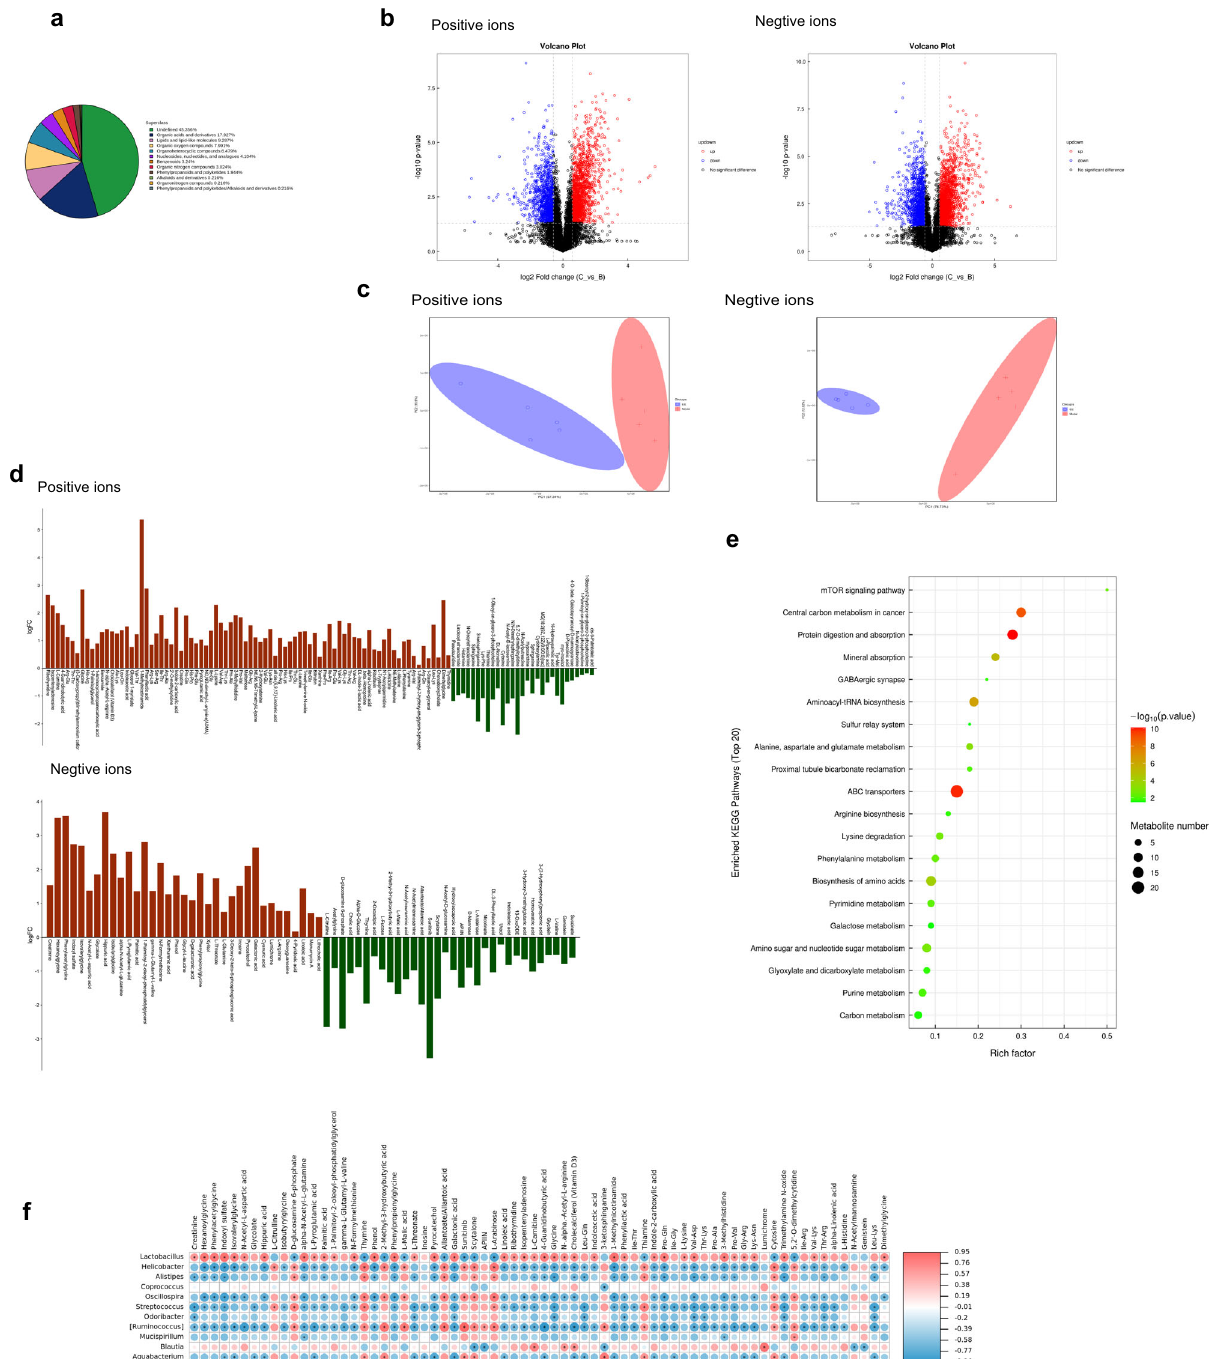
Fig. 4 EE supplementation changed the fecal metabolites in irradiated mice. a Statistics of chemical Taxonomy of metabolites. b The volcano plot of the fecal metabolites. (Metabolites with FC > 1.5 and p value < 0.05 were represented in red; metabolites with FC < 0.67 and p value < 0.05 were represented in blue. Non-signi fi cant metabolites are shown in black). c The PCA plot of the fecal metabolites. d Differential multiple analysis of metabolites with signi fi cant differences. (OPLS-DA, VIP > 1 and p value < 0.05, student ’ s t-test). e The results of the metabolic pathway enrichment analysis. f Correlation analysis among the gut microbiota and metabolites with signi fi cant differences. Spearman ’ s correlation analysis was performed by data of the Model group and EE group ( n =